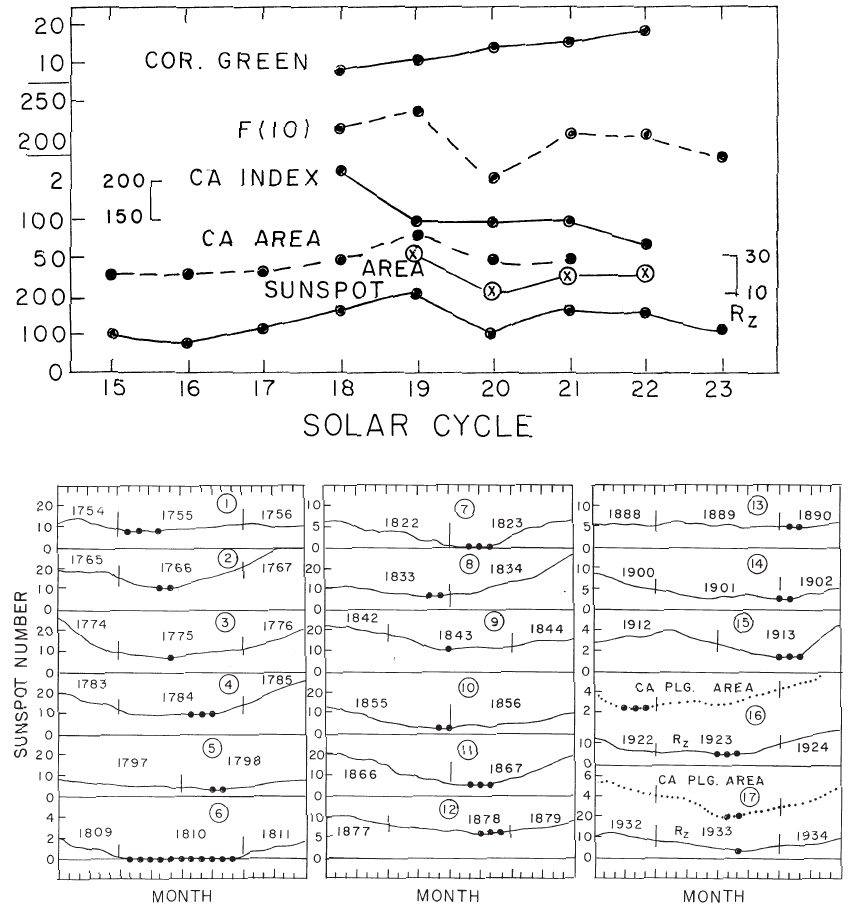
Fig. 8. Plots of the 12-month moving averages of sunspot number Rz during years of minima of sunspot cycles 1–17. In the plots for cycles 16 and 17, the dashed line represents 12-month mov- ing averages of the Calcium Plage